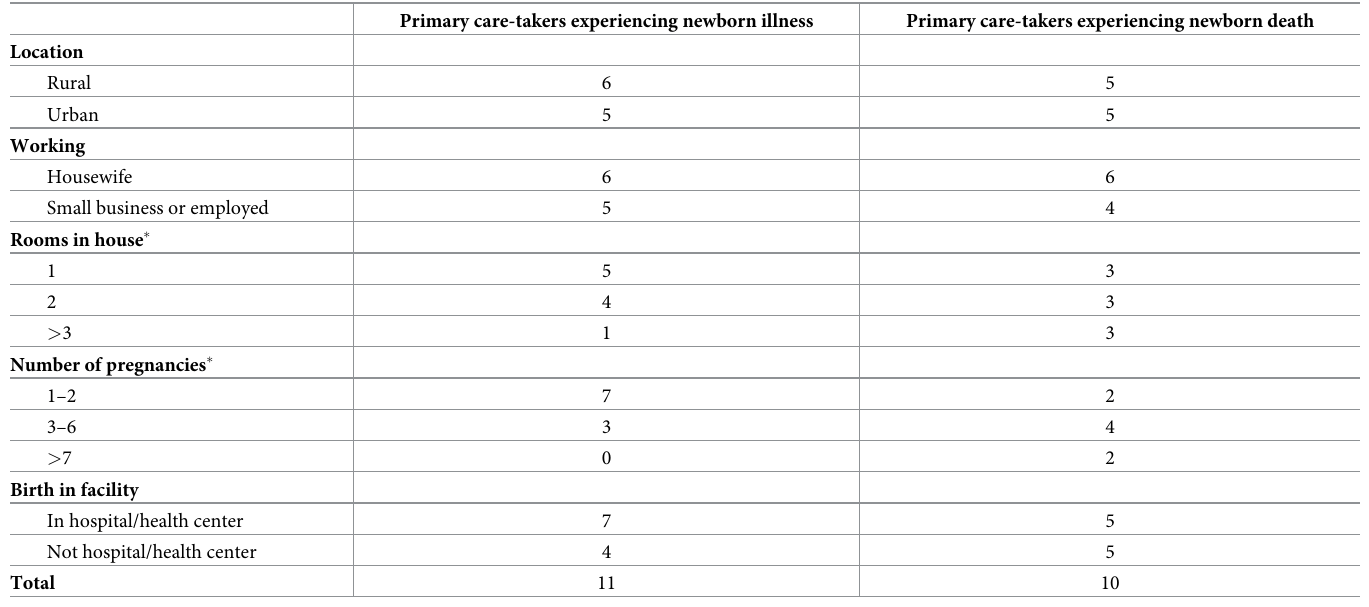
Table 2. Basic characteristics of primary care-takers experiencing newborn illness and